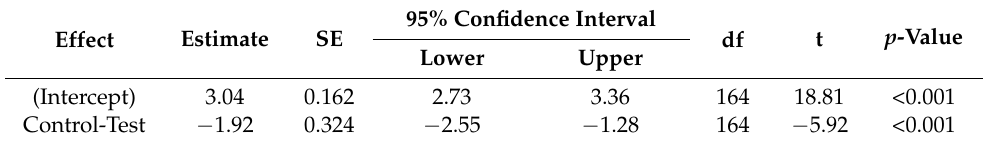
Figure 2. The mean number of ticks escaping (into chamber a) in the ultrasonic treatment and control (no sound) arenas. Error bars represent standard errors. An asterisk (*) above each pair of bars indicates a statistically significant difference. Table 3. Parameters estimated by the best fit generalized linear mixed model